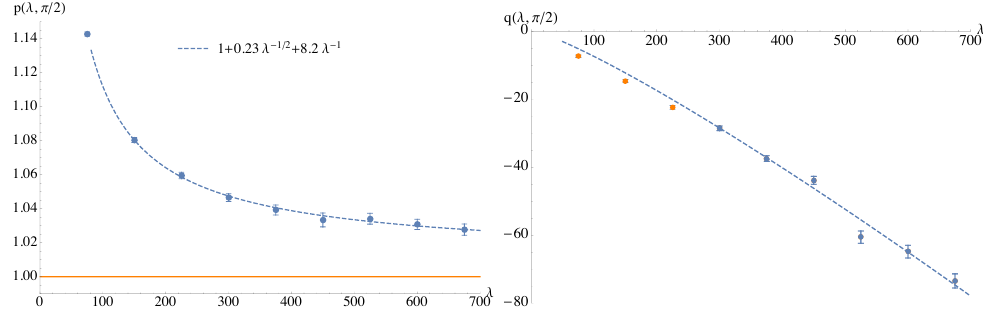
) (right) for the quiver at the point λ 2 = 3 λ 1 , with 2